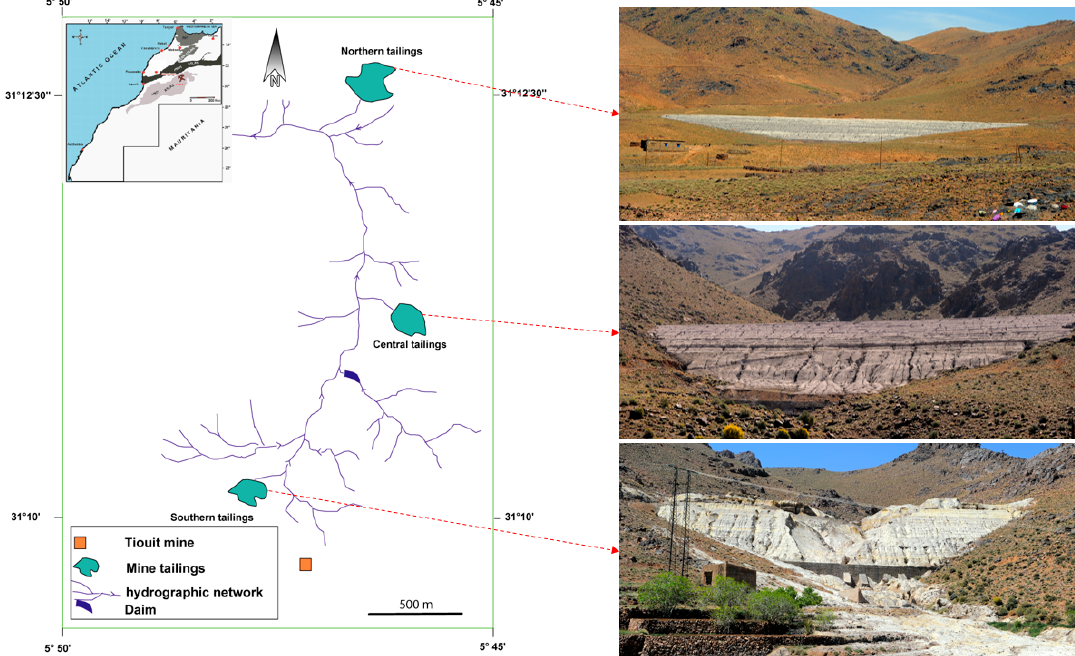
Figure 1. Tiouit mine site location and photographs of northern, central, and southern tailing ponds.